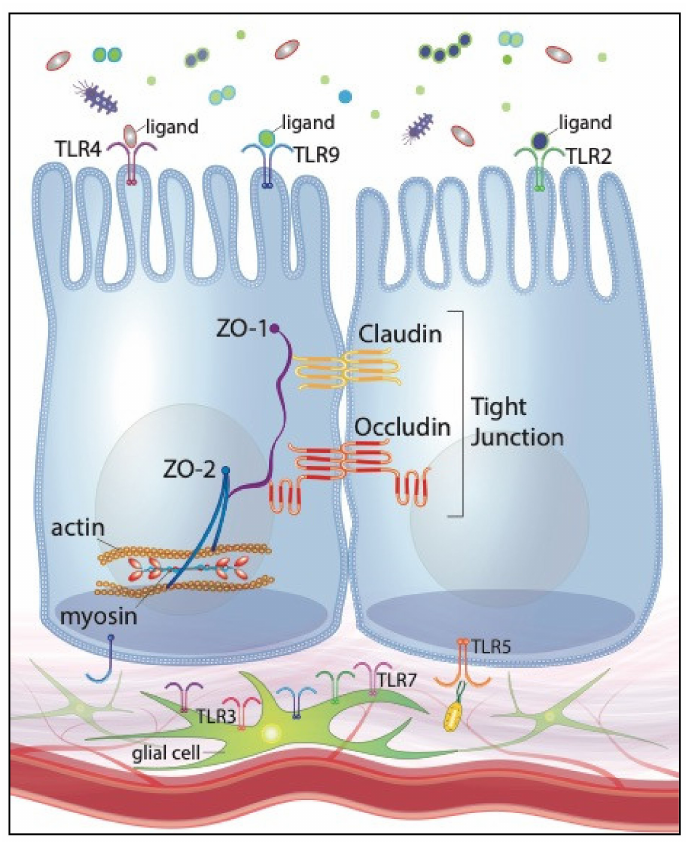
Figure 1. Toll-like receptor expression of intestinal epithelial cells (IECs) and the enteric glial cell (EGC) network, illustrating positive effects on tight junctions and intestinal barrier